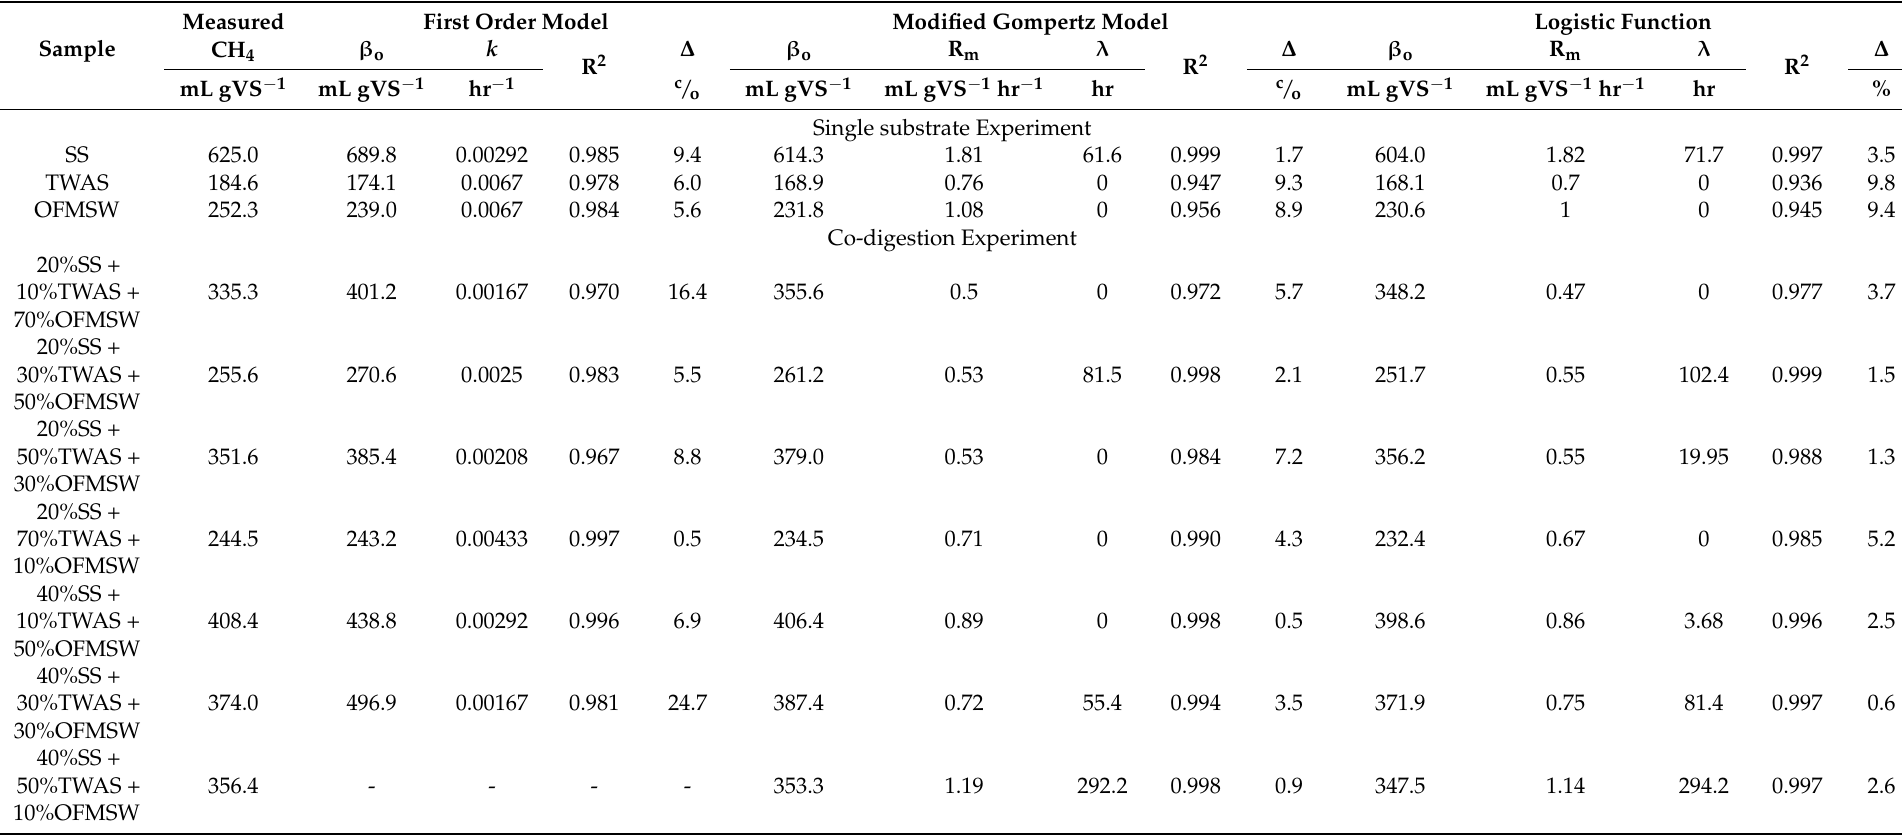
Table 4. Comparison of the parameters estimated from the various